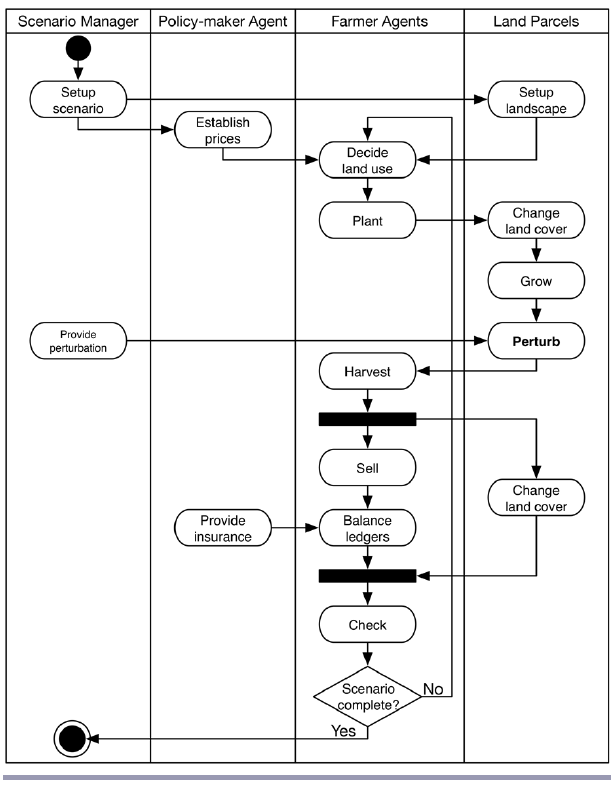
Fig. 2 . Model activity diagram describing interactions among model components during the simulation of a scenario. Black bars indicate points of divergence or reconvergence of parallel